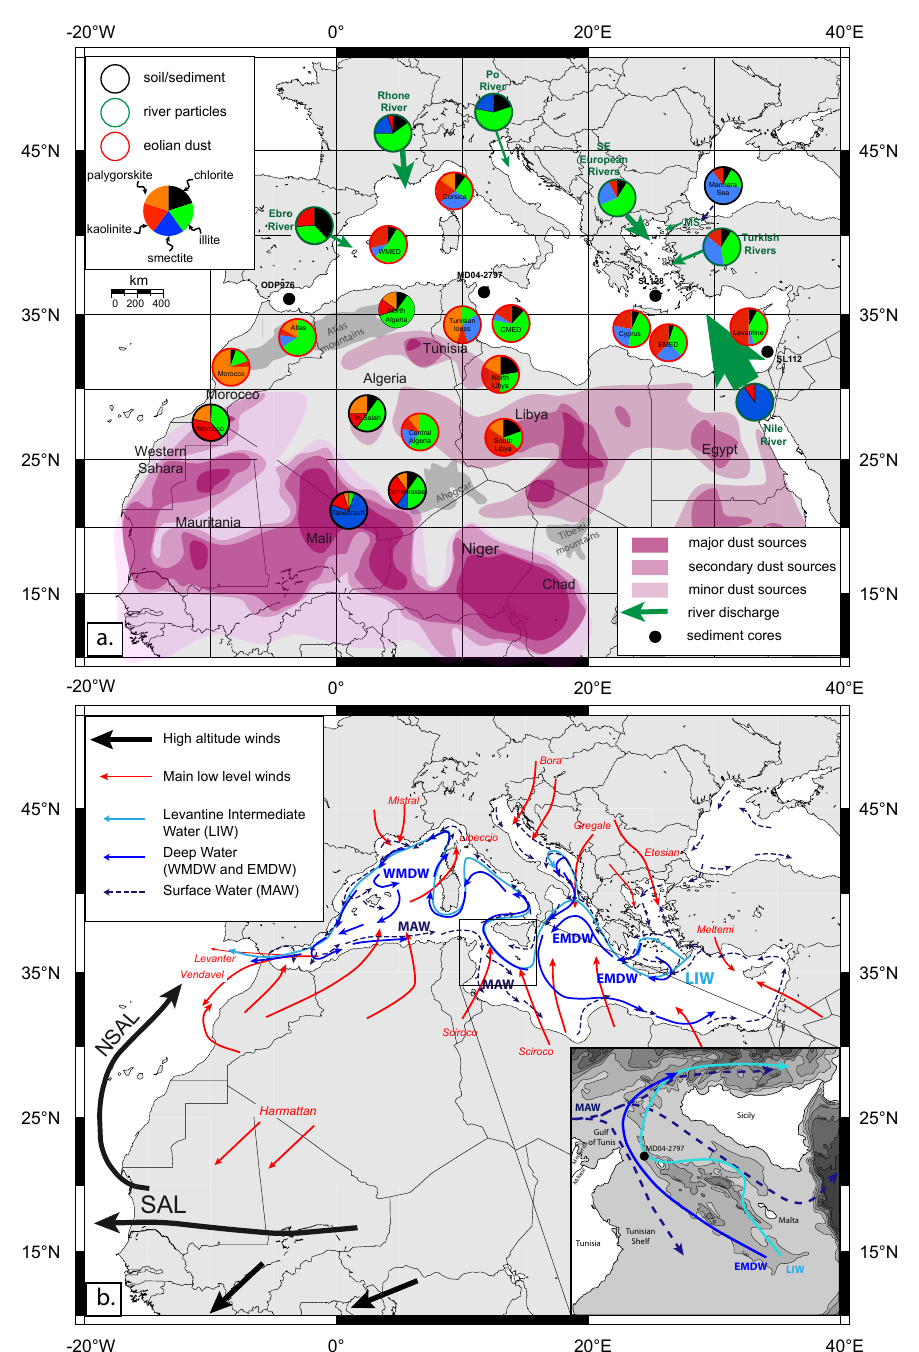
Fig. 1. Geographical settings: (a) clay mineralogy of peri-Mediterranean river particles (green circles), sediments/soils (black circles) and dust particles (red circles) modified from Bout-Roumazeilles et al. (2007); additional data from Cyprus and Levantine Sea: e.g. Hamann et al. (2009); data from northwest Aegean province and West Turkey province: e.g. Ehrmann et al. (2007a); data from Marmara Sea: Armynot du Chˆatelet et al. (2013); North and South Libya dust from O’Hara et al. (2006). Position of the sediment cores mentioned in this study. Major, secondary and minor dust sources modified from D’Almeida (1986); Brooks and Legrand (2000); Caquineau et al. (2002); Prospero et al. (2002); Israelevich et al. (2002); Goudie (2003); Formenti et al. (2011a). (b) Main low level (red arrows) and altitude winds (black arrows), rivers supply (green arrows, thickness proportional to annual suspended supply) in the Mediterranean Sea. SAL: Saharan Air Layer, NSAL: northern branch of the Saharan Air Layer. The limit between Sahara and Sahel is reported. Main surface (MAW), intermediate (Levantine Intermediate Water, LIW) and deep water (WMDW and EMDW) masses (Saliot, 2005). The inset shows the detailed bathymetry and oceanic circulation of the study